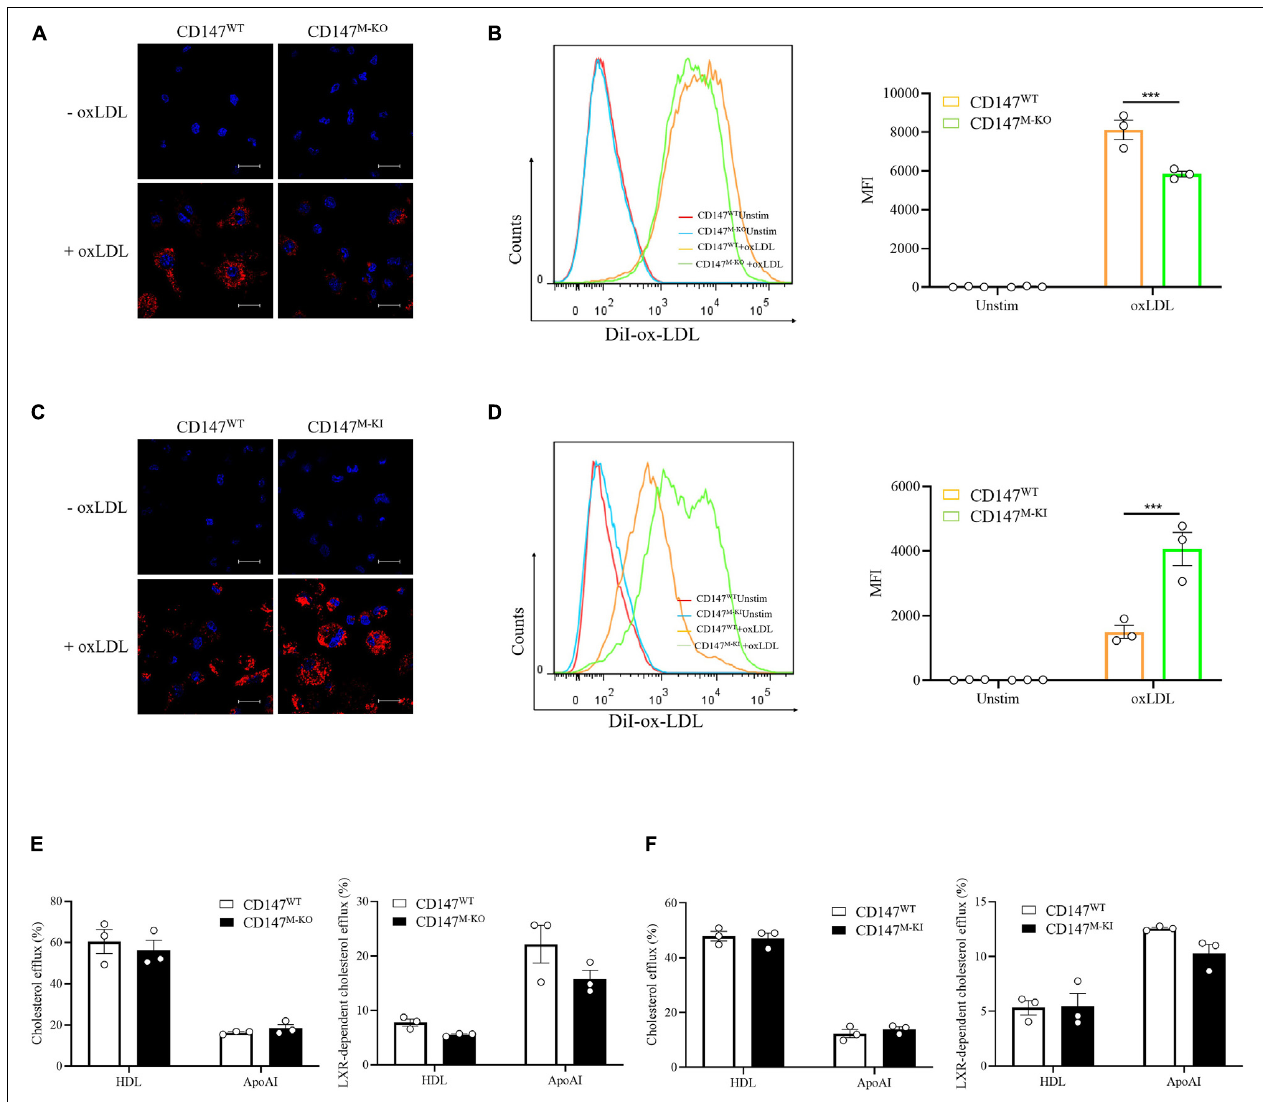
FIGURE 6 | Macrophage CD147 regulates foam cell formation by mediating ox-LDL uptake. (A,B) BMDMs from CD147 WT or CD147 M − KO mice were examined using either confocal microscopy (A) or flow cytometry (B) after treatment with DiI-oxLDL (20 µ g/mL) for 4 h. The scale bar is 20 µ m. Right panel: Quantification of MFI of DiI-oxLDL in CD11b + F4/80 + BMDMs. (C,D) BMDMs from CD147 WT or CD147 M − KI mice were examined using either confocal microscopy (C) or flow cytometry (D) after treatment with DiI-oxLDL (20 µ g/mL) for 4 h. The scale bar is 20 µ m. Right panel: Quantification of MFI of DiI-oxLDL in CD11b + F4/80 +